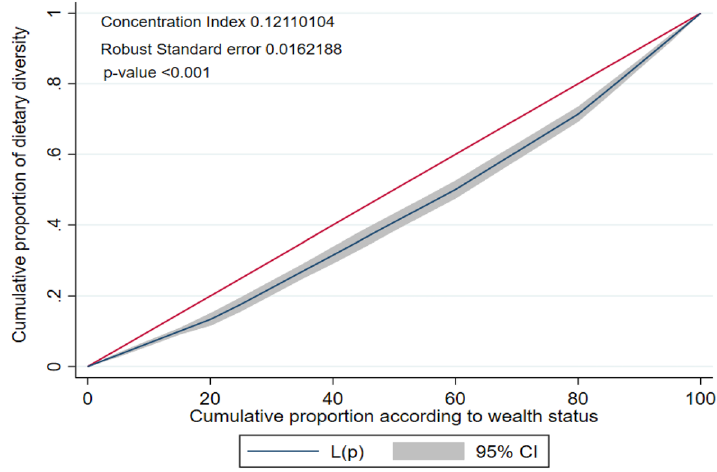
Figure 3. Concentration curve of dietary diversity against the wealth status.